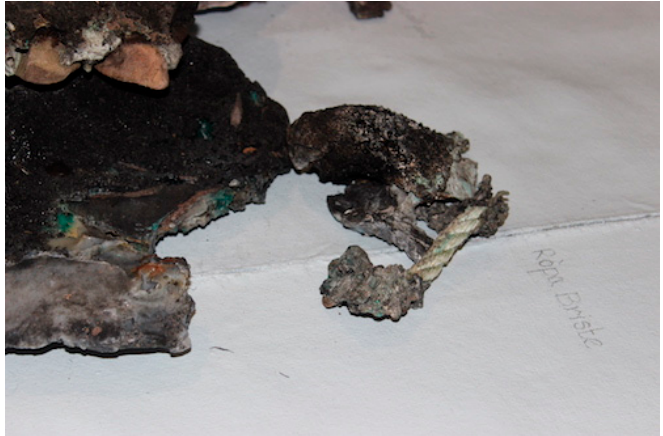
Figure 4. Archipelago : detail. Photograph created by the author.